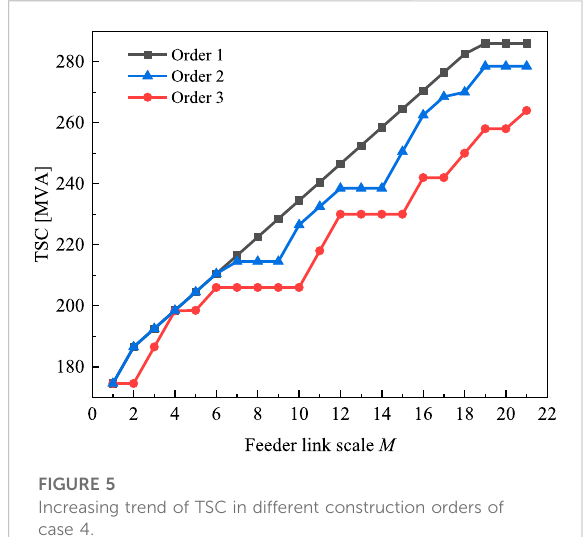
FIGURE 5 Increasing trend of TSC in different construction orders of case